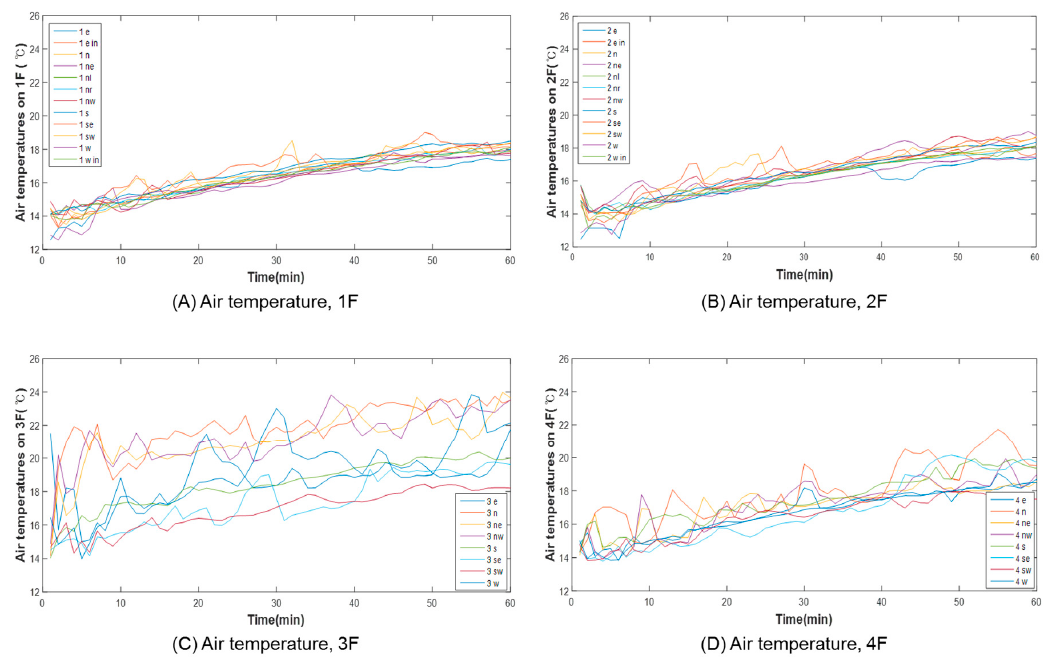
Figure 5. Distribution of air temperature on each floor.